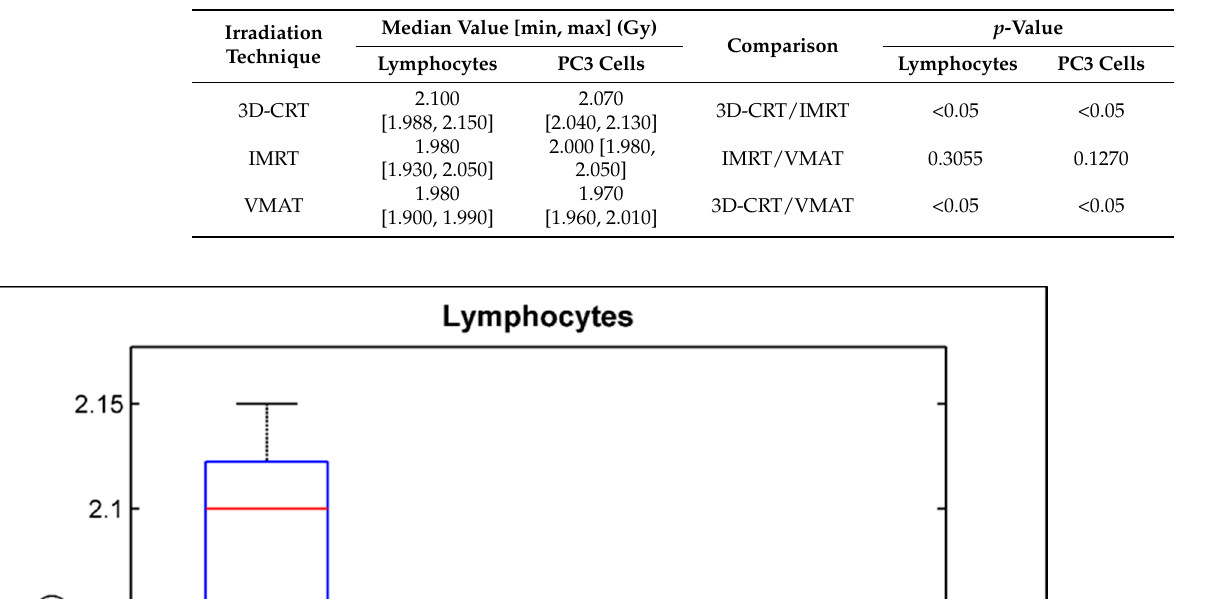
Table 3. Comparison of the median biological absorbed dose between the 3D-CRT, IMRT, and VMAT technique for the lymphocytes and PC3 cells.